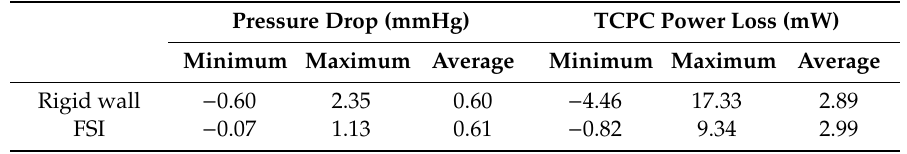
Table 4. Comparison of pressure drop and TCPC power loss between the rigid wall and fluid-structure interaction (FSI) simulations over the cardiac cycle. TCPC: total cavopulmonary connection.